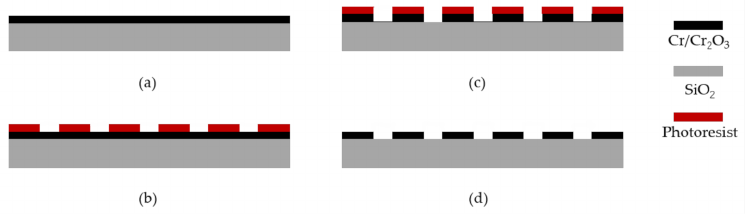
Figure 9. ( a )–( d )Fabrication process steps used to prototype the two-region diffraction micro-grating